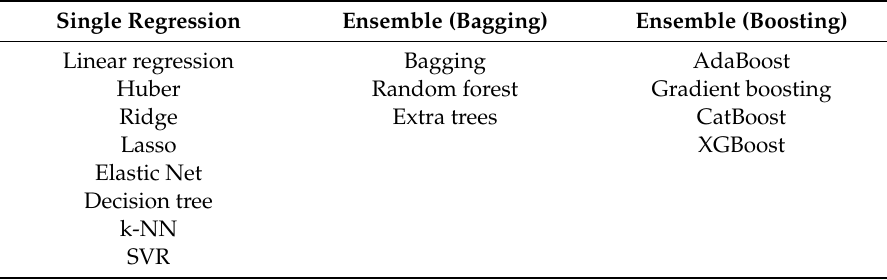
Table 3. Machine learning